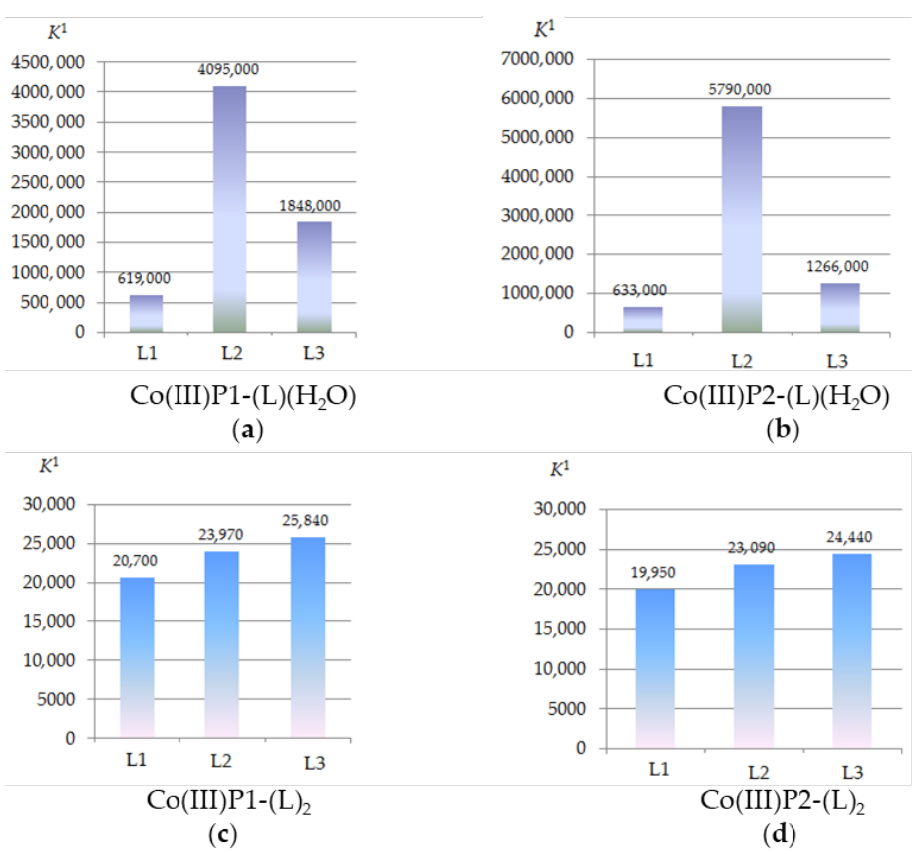
a The total energy of Co(III)P-(L)(H 2 O) complexes formation according to Equation (1а) (ΔG = −RT ln K 1 ). b The total energy of Co(III)P-(L) 2 complexes formation from Co(III)P-(L) 2 according to Equation (1b) (ΔG = −RT ln K 2 ). c The energy of hydrogen bonding in the complex Co(III)P-(L)(H 2 O) ( ∆ G HB = ∆ G Co(III)P-L − ∆ G Co(III)P-L1 ) (L-ligand (L1), the compound that does not form hydrogen bonds). d The calculated value of the hydrogen bond length (OH ··· O-L; r, Å).